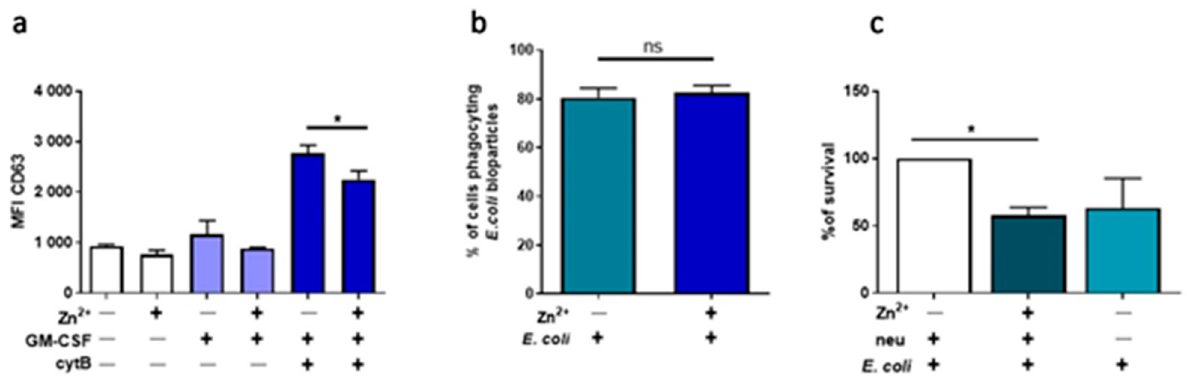
Figure 3. Zinc affects degranulation and the number of bacteria but does not alter phagocytosis. Neutrophils were incubated with or without 10 µ M zinc and ( a ) primed with 25 ng/mL GM-CSF, incubated with 5 µ g/mL cytochalasin B, 10 nM C5a, immunolabeled and analyzed by flow cytometry; ( b ) incubated with E. coli bioparticles and analysis of the percentage of cells phagocyting was analyzed by flow cytometry; ( c ) incubated with alive E. coli at the multiplicity of infection 10:1 ( E. coli : neutrophils) for 3 h and the number of colonies of survived bacteria from the collected supernatants were counted. One-way ANOVA with post hoc ( a ) Sidak’s test, ( b ) Holm–Sidak’s test, ( c ) Kruskal–Wallis test. The means + SEM are shown; ( a ) n = 3, ( b ) n = 6, ( c ) n = 4; * ( p ≤